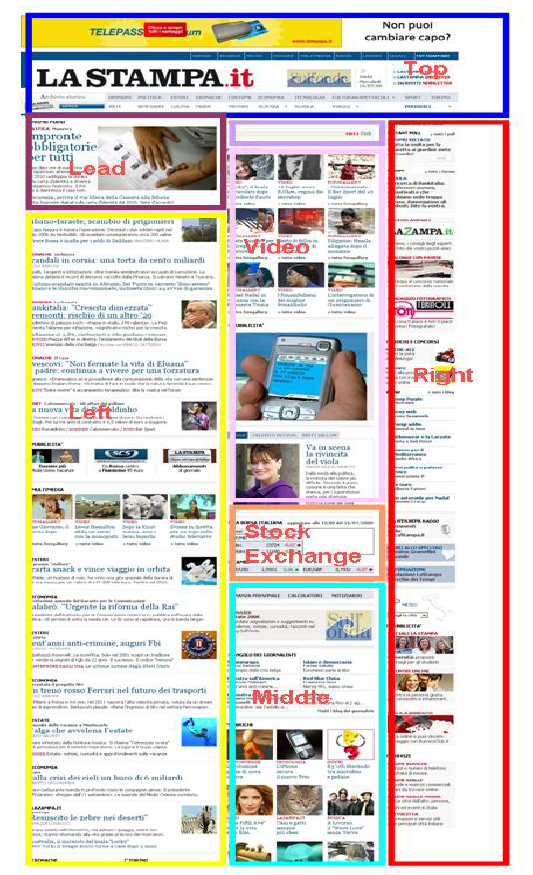
Figure 2 - Areas of Interest on La Stampa home page (CS2).